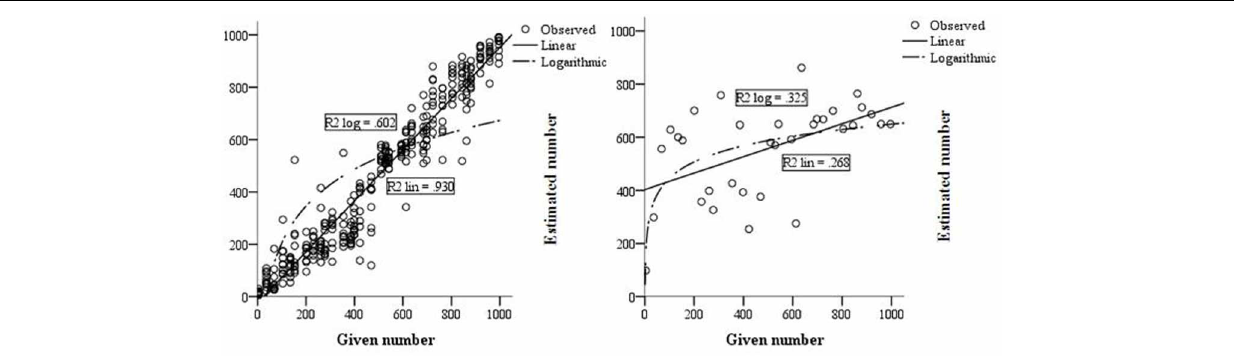
FIGURE 3 | Linear and logarithmic fit of L (right) and the control group (left) on the 0–1000 number line